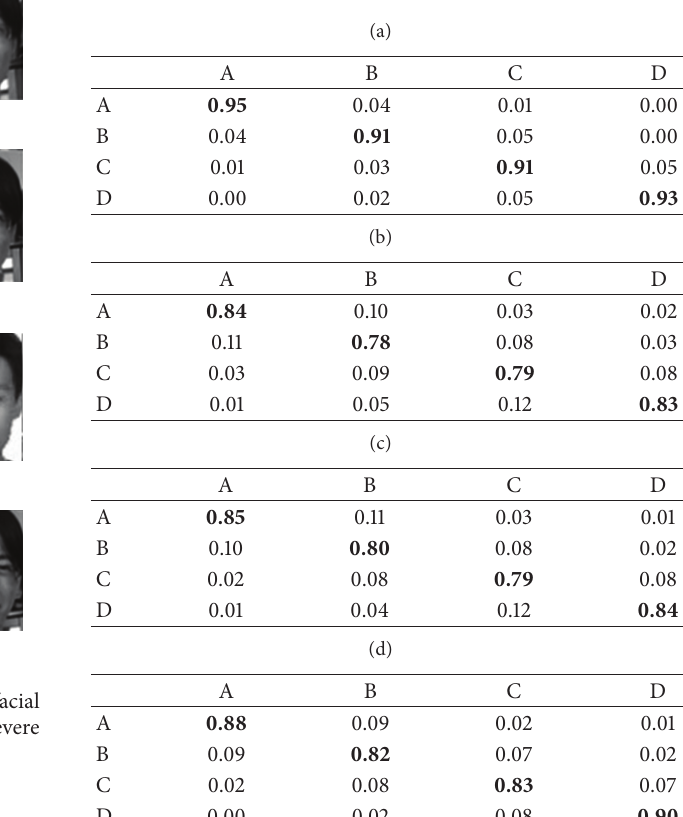
Table 1: Confusion matrix for pain recognition.